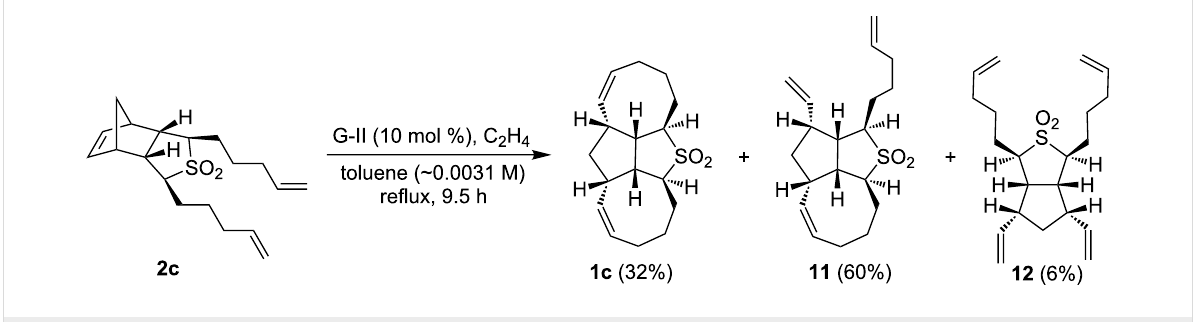
Scheme 5: RRM of the dipentenyl sulfone 2c .